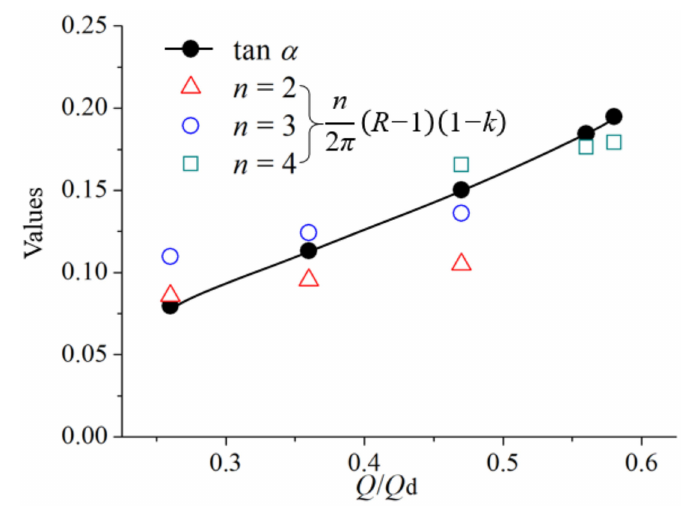
Figure 8. Experimental validation of the critical